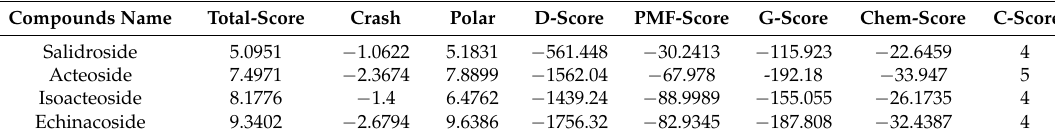
Table 1. Molecular docking analysis of